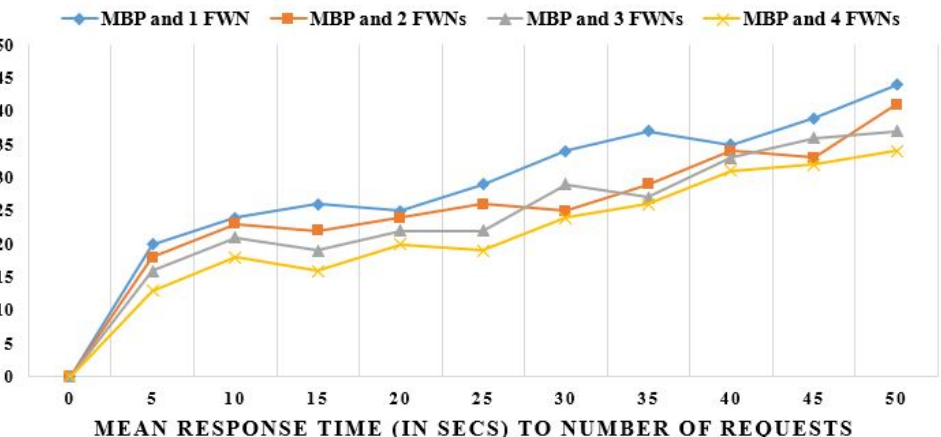
Figure 12. The mean response time (in secs) with respect to the number of requests by users.